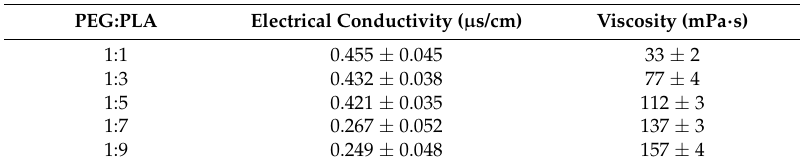
Table 1. Properties characterization of spinning solutions with the different weight ratio (polyethylene glycol:polylactide, or